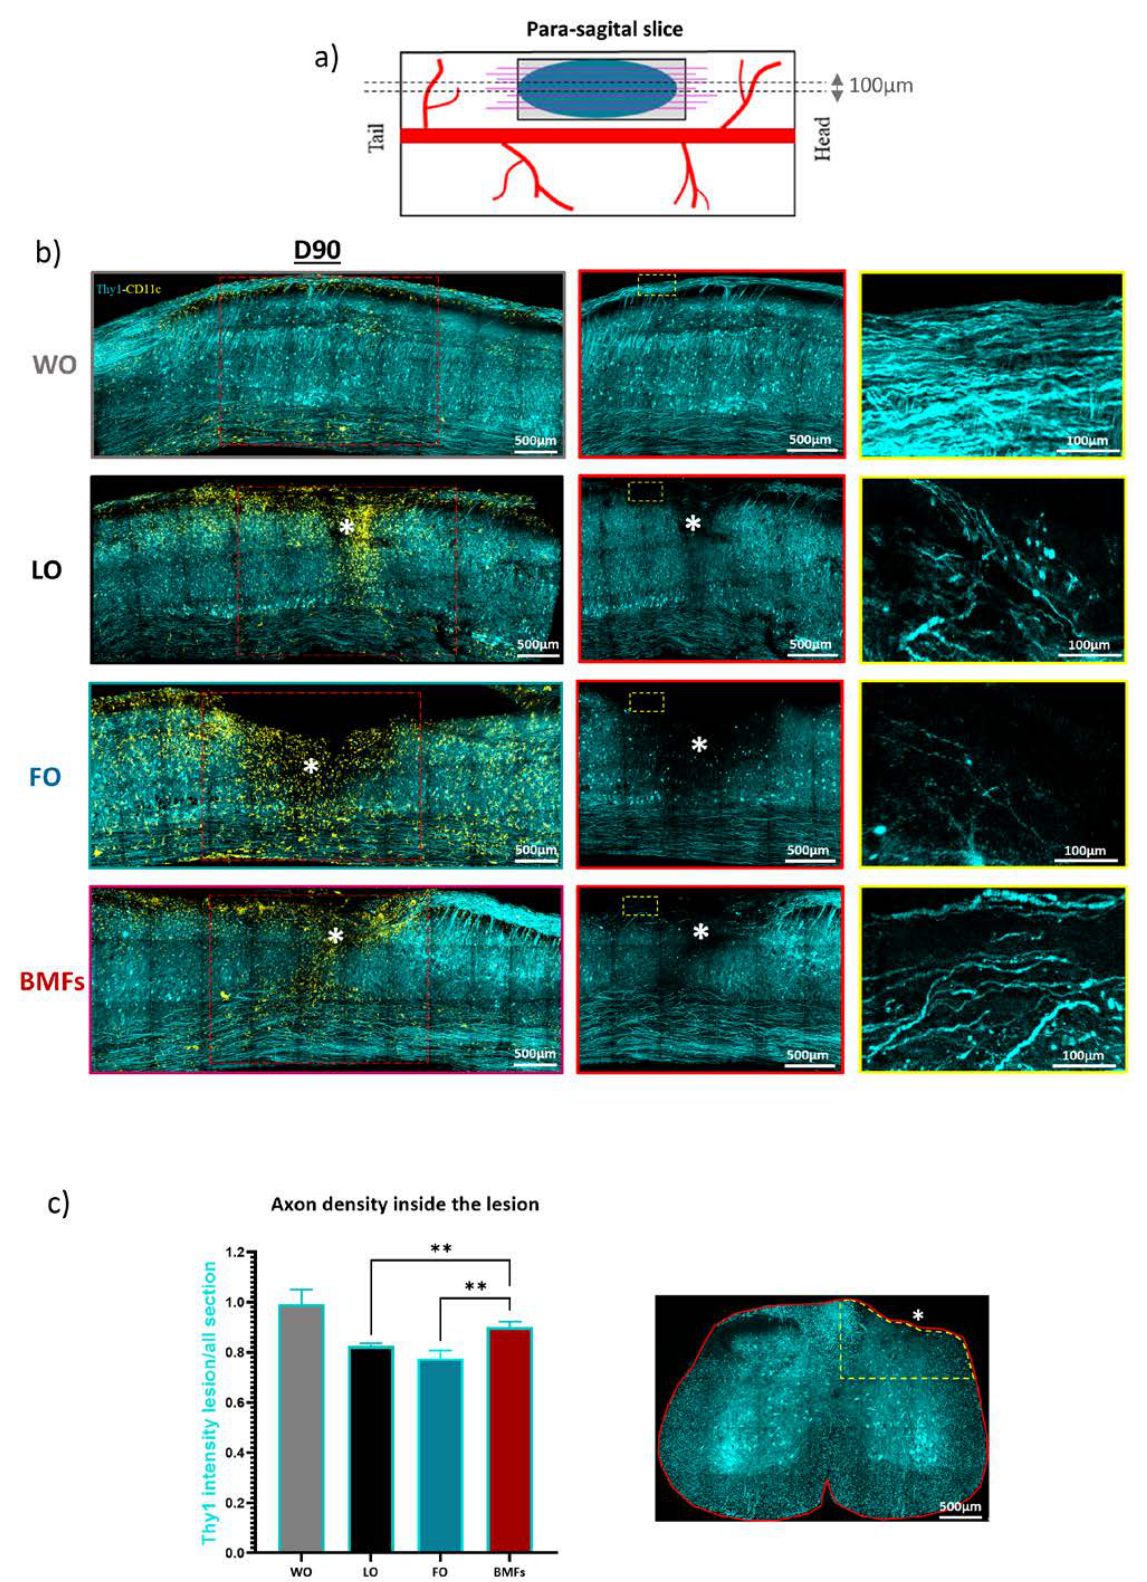
Figure 7. Rostro-caudal distribution of chronic inflammation and axonal densities on D90 post lesion. ( a ) The rostro-caudal distribution of chronic inflammatory status was evaluated from parasagittal 100 µ m thick spinal sections taken in the center of lesion as shown in scheme. ( b )